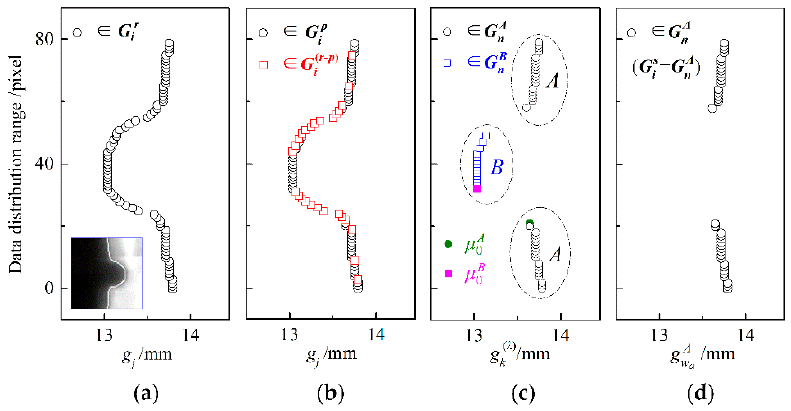
Figure 5. Dynamic solution procedure of the ISDC algorithm: ( a ) distribution of raw width data; ( b ) data preprocessing; ( c ) dynamic clustering; ( d ) cluster selection.